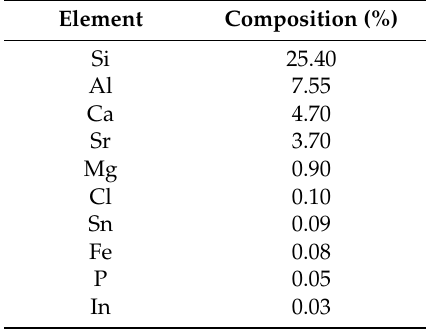
Table 2. Elemental chemical composition of the liquid crystal display (LCD) panel using X-ray fluorescence (FRX).